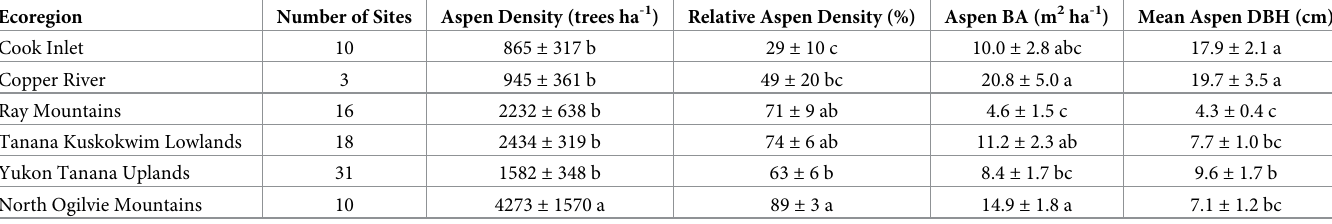
Two sites from the Yukon-Old Crow Basin ecoregion were combined within the North Ogilvie Mountains ecoregion for statistical purposes as all 10 sites along the stretch of the Yukon River between Circle and Eagle River were within similar landscapes. Values within columns with different letters indicate significant differences among ecoregions for variables at P < 0.05